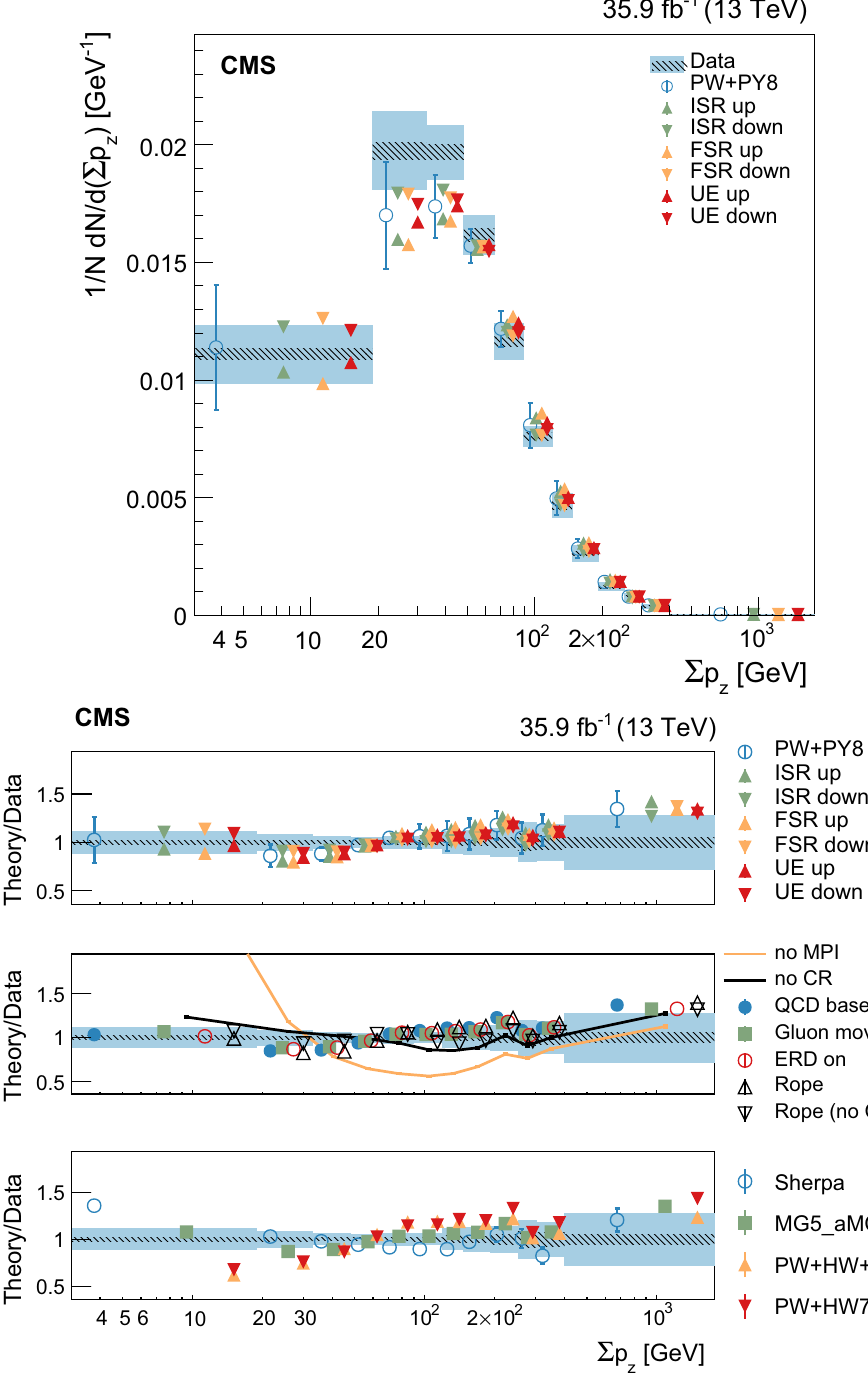
Fig. 8 Normalized differential cross section as function of (cid:2) p z , compared to the predictions of different models. The conventions of Fig. 4 are